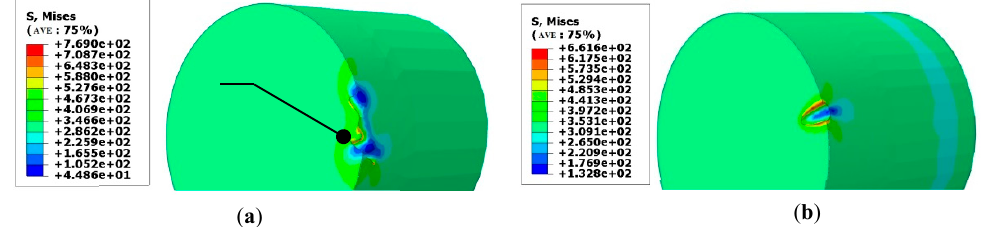
Figure 15. Stress contours of random pit model and two semi-ellipsoidal pit models with mass loss rate of 0.25%. ( a ) Random corrosion pit; ( b ) Hemi-ellipsoidal corrosion pit ( λ = 0.25).